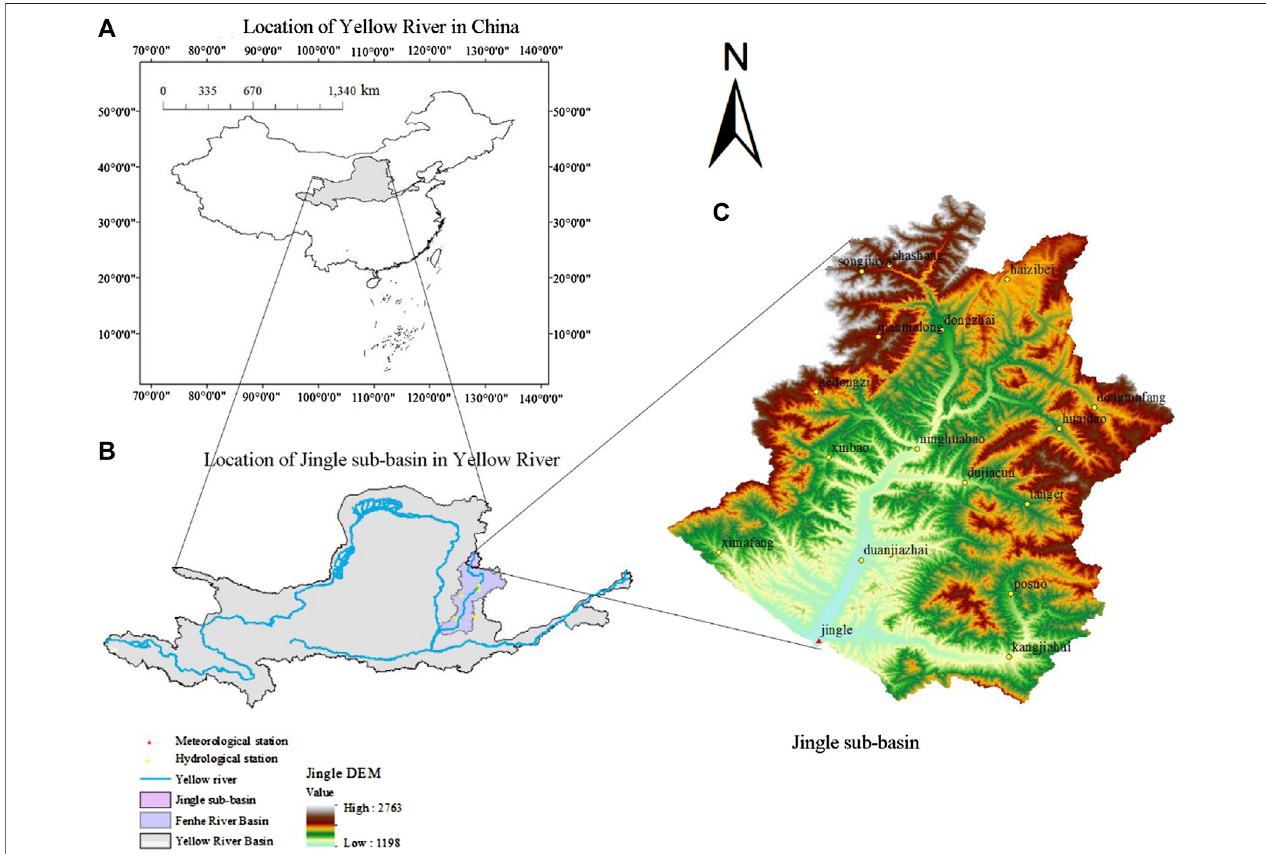
FIGURE1| TopographicmapoftheJinglesub-basin. (A) DescriptionofYellowRiverinChina; (B) Description oftheJinglesub-basinintheYellowRiverBasin; (C) Control catchment of the Jingle station in Fenhe River and distribution of rainfall gage stations.